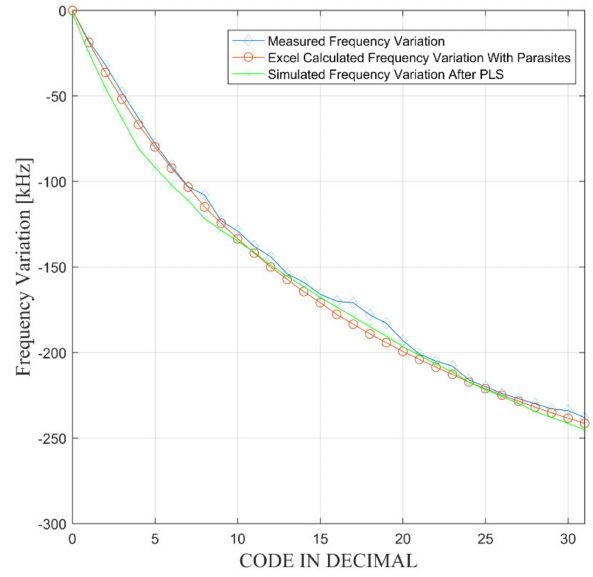
Figure 9. Frequency variation as a function of the binary word.